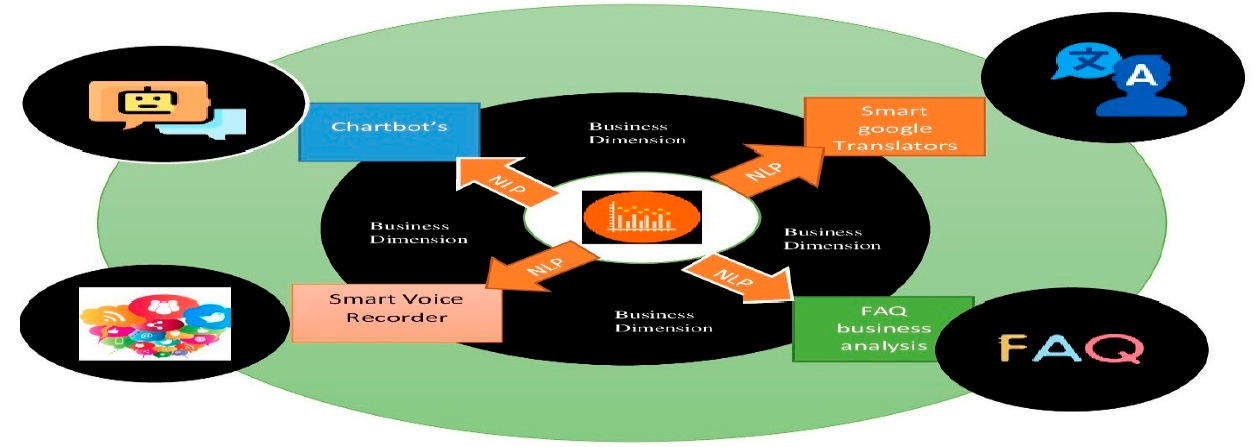
Figure 1. NLP business dimension.